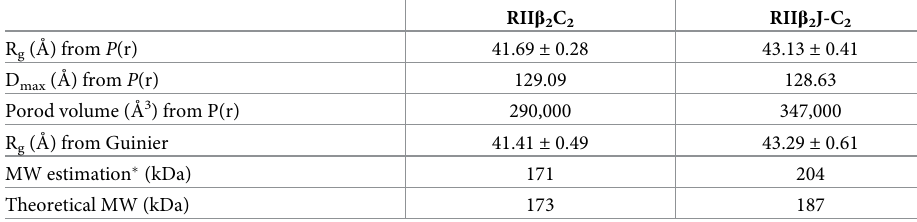
Table 2. R g and D max values of RII β 2 C 2 and RII β 2 J-C 2 holoenzymes from